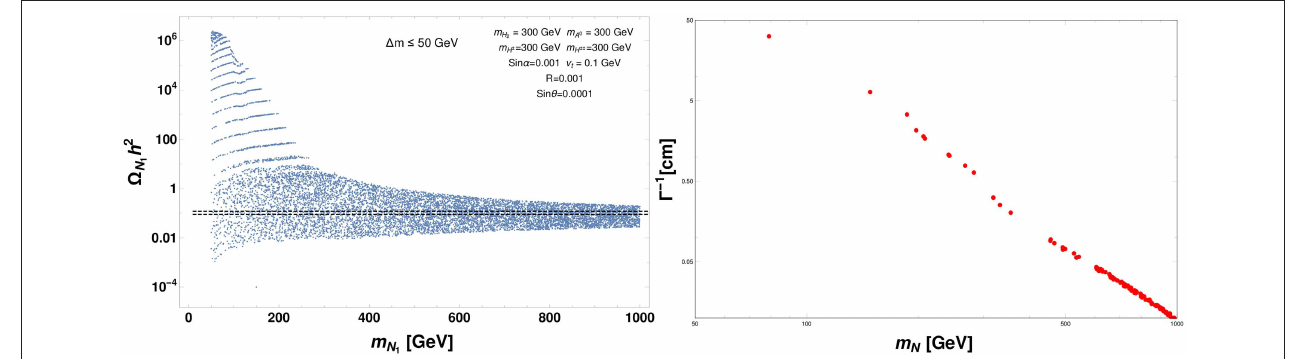
keeping fixed 1 m 50 GeV (left panel). Black dashed lines correspond to measured value of relic density 1 ≤